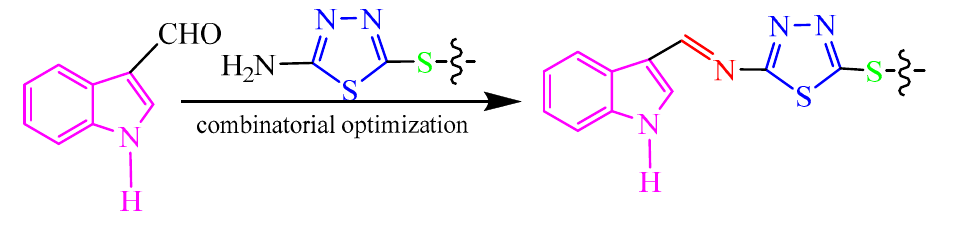
Figure 2. The structures of fungicides and antifungal activity compounds containing 1,3,4-thiadiazole.